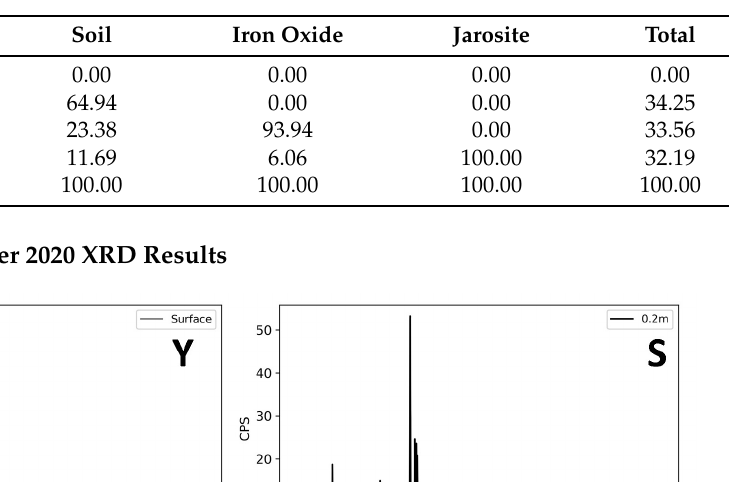
Table A14. October 2020 spectral angle mapper. Overall accuracy points: 117/146, overall accuracy: 80%, kappa coefficient: 0.7009.